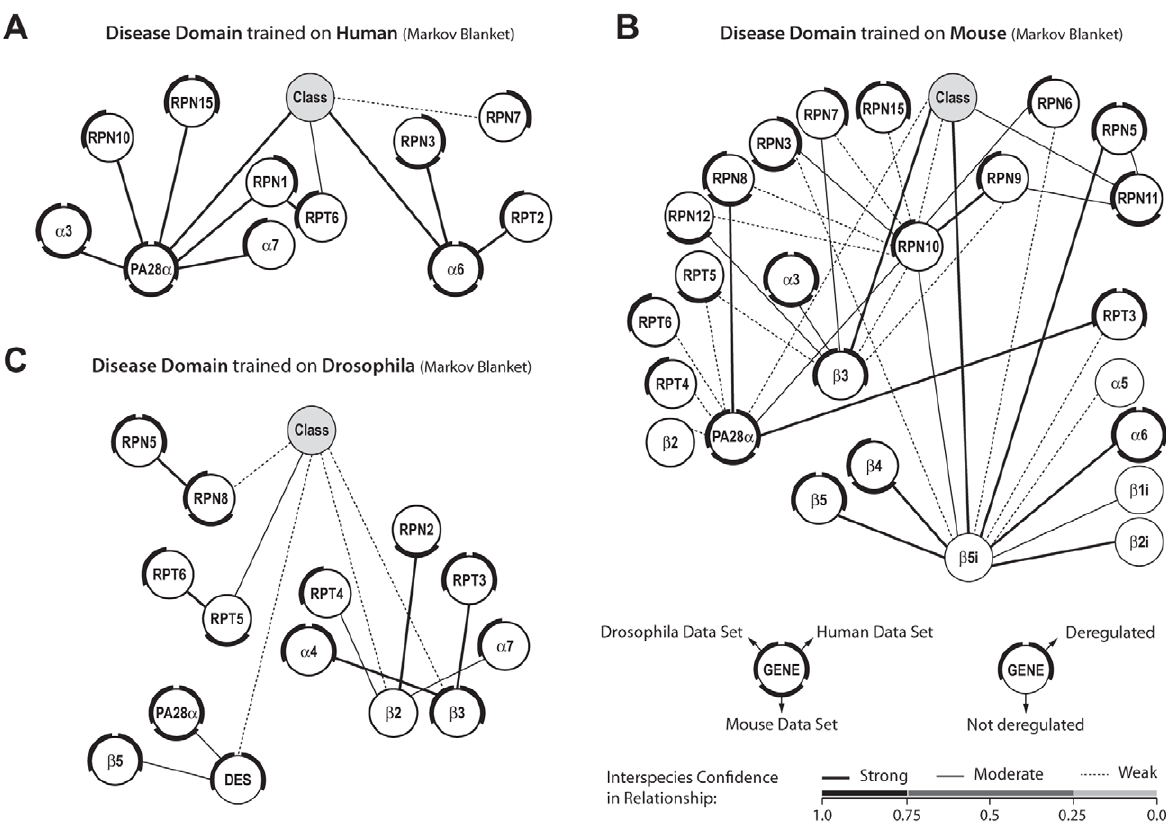
Figure 7. Interspecies disease domains. These interspecies class network structures are learnt on human ( A ), mouse ( B ), or Drosophila ( C ) dataset and optimized across species. Class network structures are presented according to Markov blanket criteria. Nodes represent genes. The outer ring reflects deregulation in the expression in the different species ( a , b ). Relationships are depicted with lines that represent different degree of confidence in relationships (described in c ).